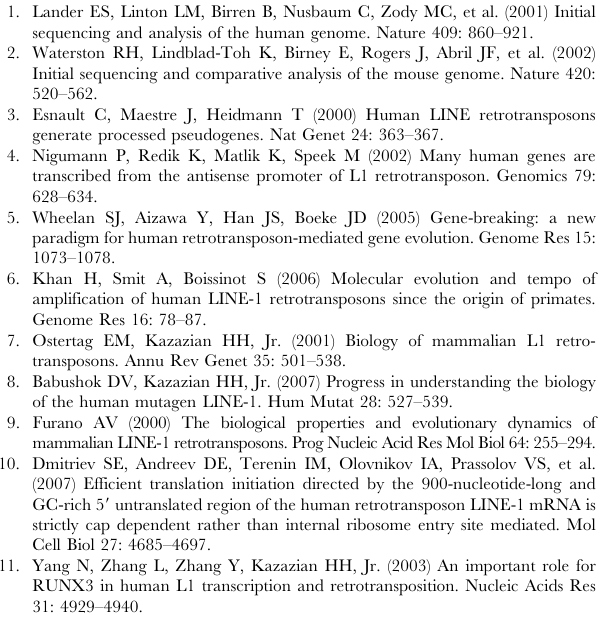
Table S2 The distribution of L1 elements in mouse chromo- somes and the statistical analysis of correlations between chromosome size and L1 density.